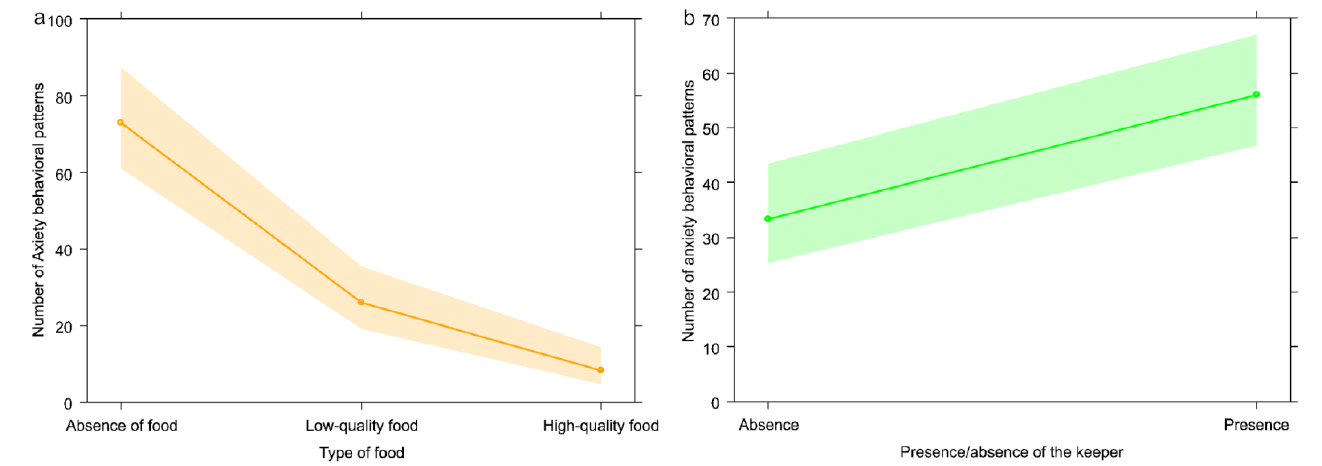
Figure 2. Effect plot of the variables with a significant effect on anxiety behavior. The number of anxiety behavioral patterns (y-axis) was highest ( a ) in absence of food (x-axis) and ( b ) in presence of the keeper.